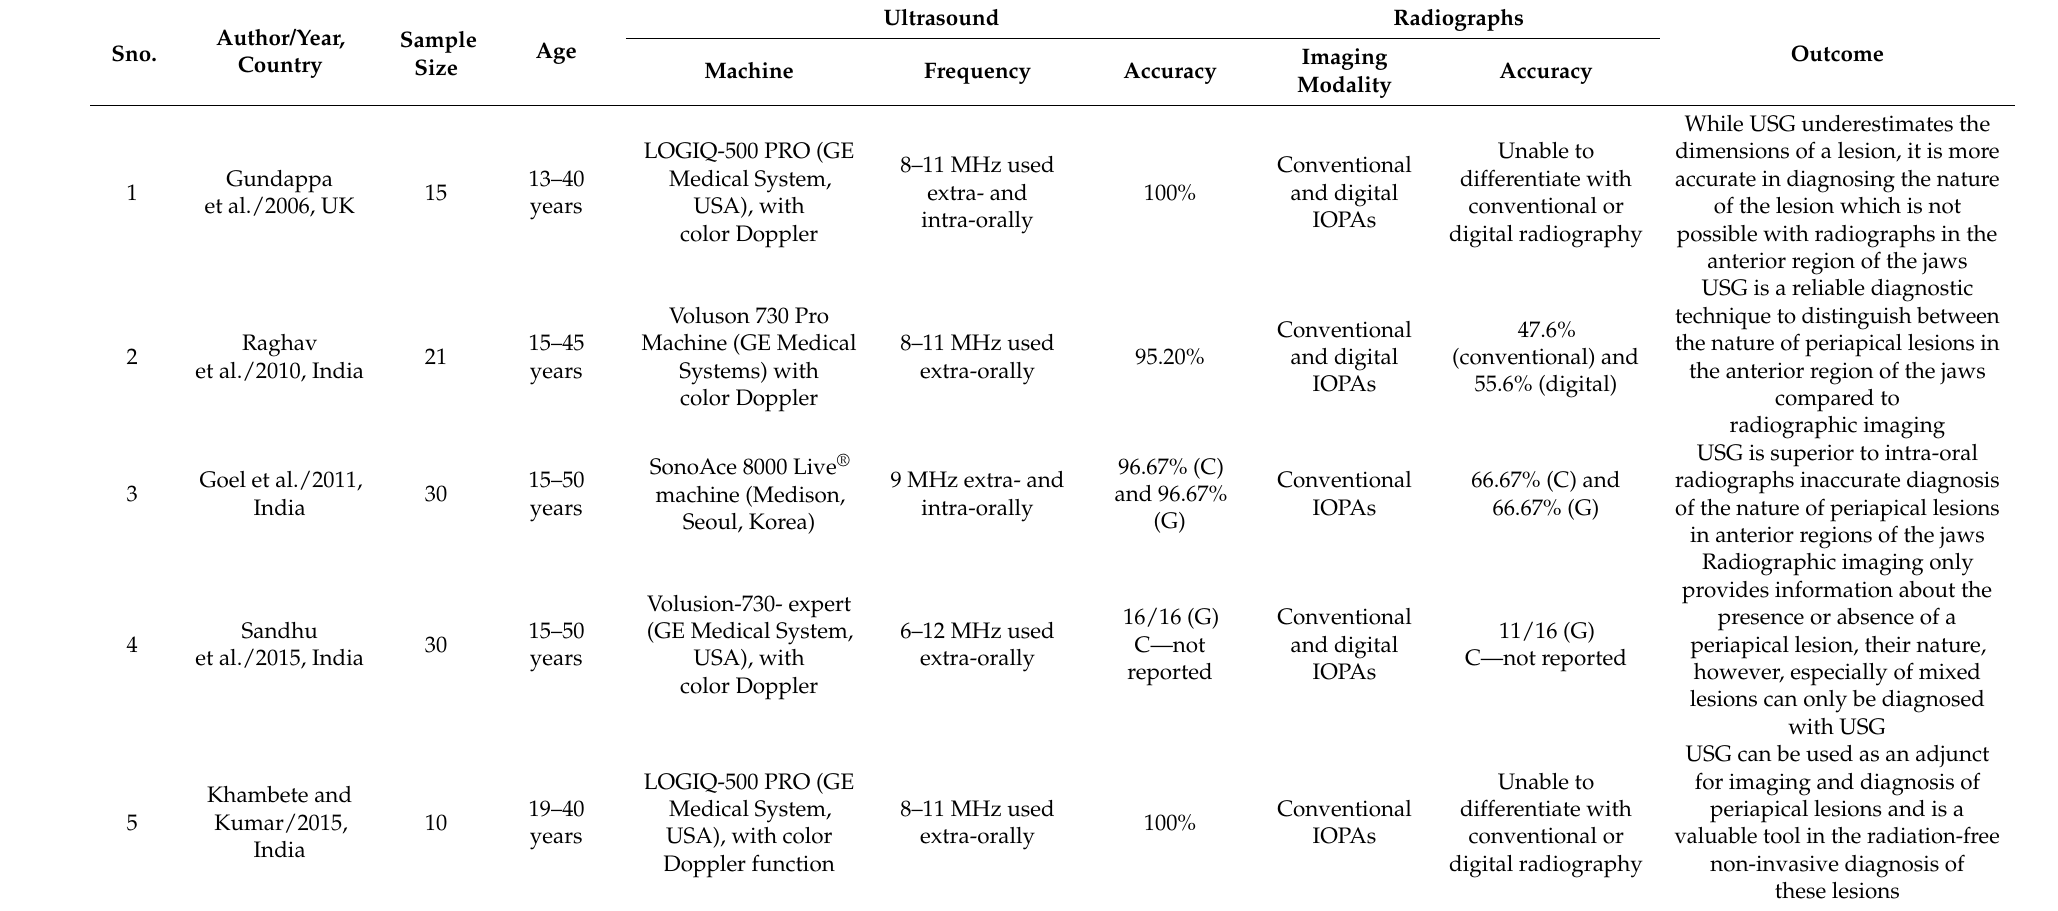
Table 2. Characteristics of selected